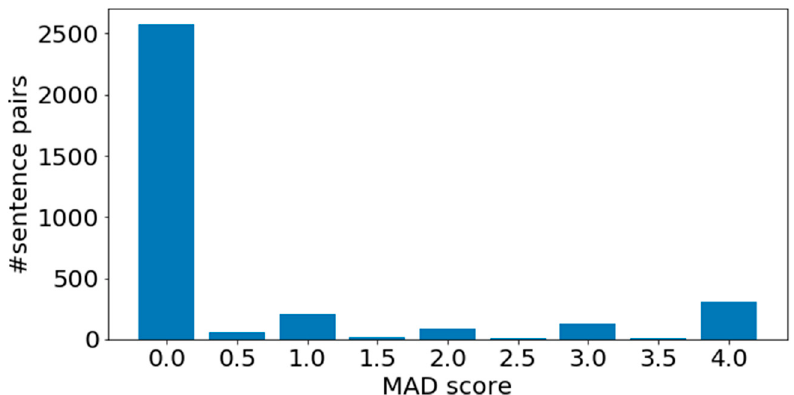
Figure 3. Distribution of MAD score for the labeled dataset.